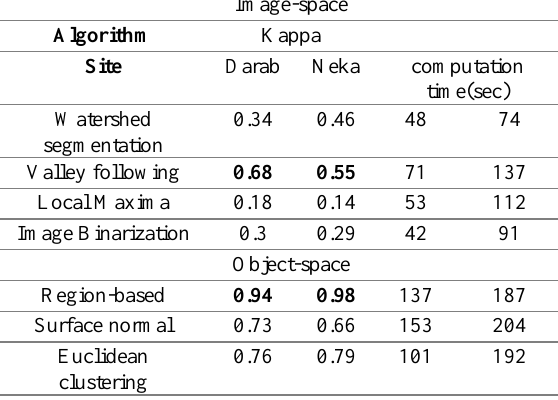
Table 2. Accuracy